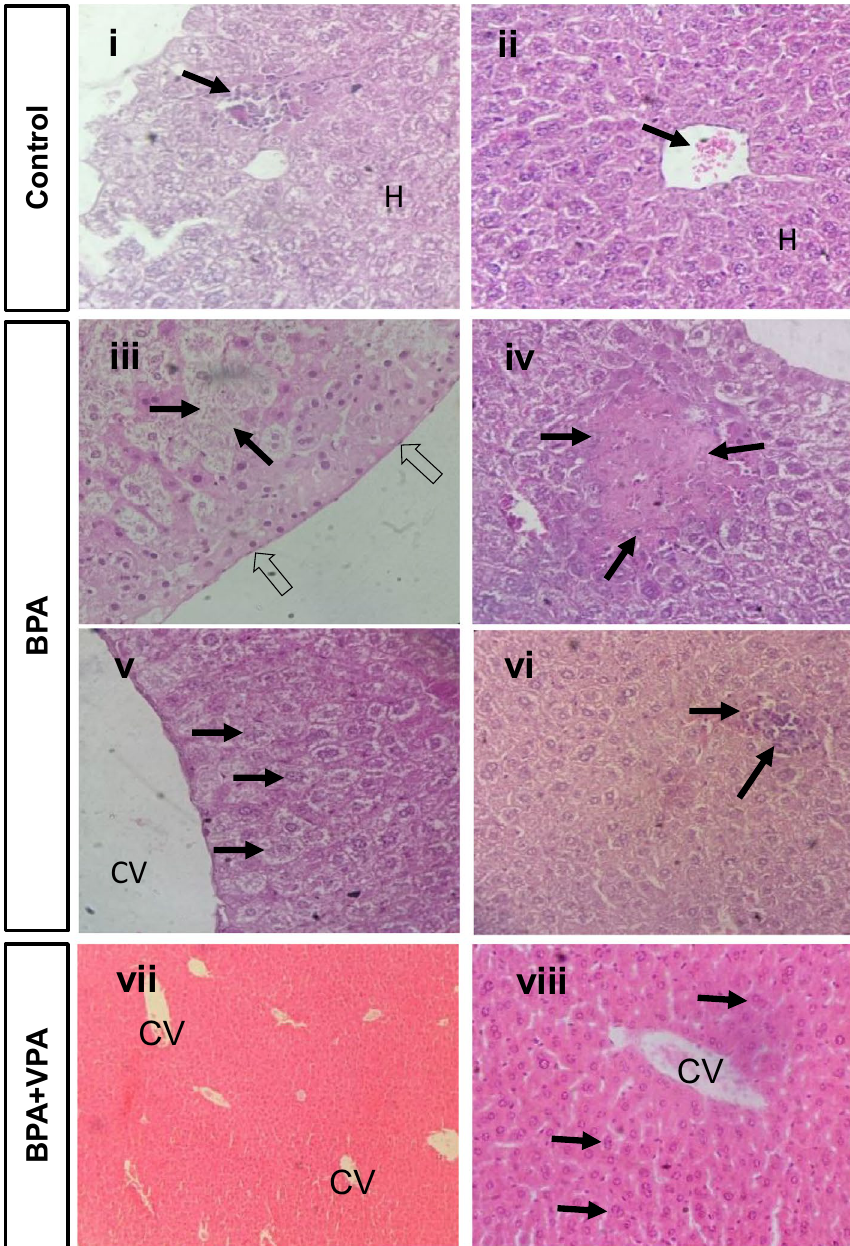
Figure 3. Representative photomicrographs of H&E-stained liver tissue of SC ( i , ii ), 3 ( iii – vi ), and 5 ( vii , viii ). Histopathological features of liver tissue of SC associated with the following outcomes: ( i ) lymphohistiocytic foci (arrow) (lobular focal minimal) with ( ii ) minimal multifocal hyperemia (arrow) and minimal multifocal erythrocyte extravasation. Histopathological features of liver tissue of BPA group associated with the following outcomes: ( iii ) hepatocellular hydropic degeneration (arrows), panlobular, close to Glisson’s capsule (open arrows); ( iv ) hepatocellular coagulative necrosis with cytoplasmic membrane disintegration, cytoplasmic eosinophilic changes, karyopyknosis, and karyolysis, accompanied by lymphohistiocytic infiltration with a few neutrophils (arrows); ( v ) microvesicular, centrilobular hepatocellular steatosis; and ( vi ) lymphohistiocytic infiltration, panlobular multifocal (arrows). Histopathological features of liver tissue of BPA + VPA group associated with the following outcomes: (vii) preserved liver architecture, including portal and central veins, predominated by a regular histomorphological, lobular architecture and ( viii ) hepatocyte proliferation and repopulation characterized by irregular and thinking of hepatocyte’s cords and enlargement of hepatocytes, including binucleated and multinucleated hepatocytes (arrows), in addition to multifocal hyperemia and minimal multifocal erythrocyte extravasation. Scale bars = 100 µm; 100 × m H&E staining. H hepatocytes, CV central vein, H&E hematoxylin and